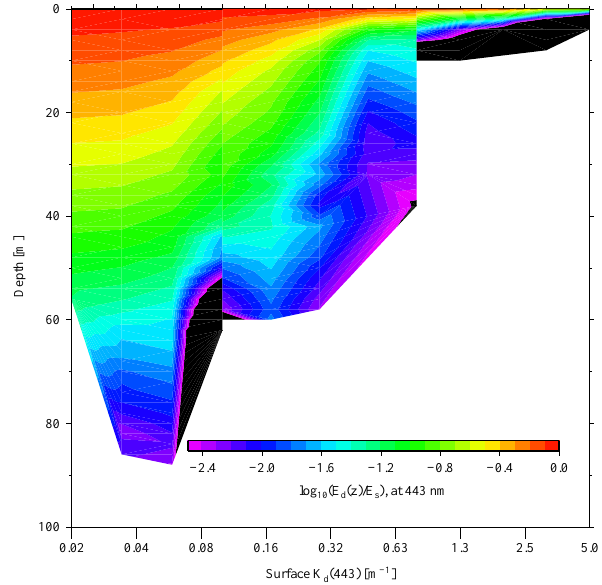
Fig. 2. Vertical profiles of the decimal logarithm of the downward irradiance normalized to its value just below the sea surface. Data are sorted as a function of the K d (443) value for the surface layer. Discontinuities are due to sorting the profiles as a function of the surface K d